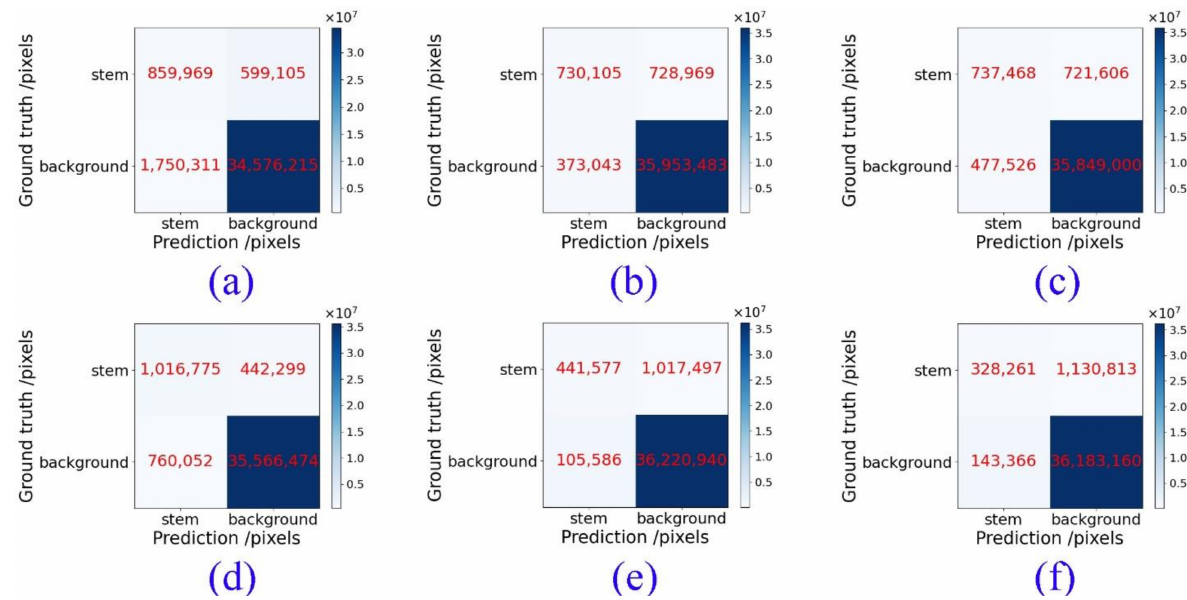
Figure 7. Confusion matrices of test results of six methods: ( a ) DEM; ( b ) Mask R-CNN; ( c ) cascaded neural network composed of DEM and Mask R-CNN; ( d ) hybrid joint neural network; ( e ) YOLACT; ( f ) cascade neural network composed of DEM and YOLACT. Different colors represent different number of pixels, and darker colors represent more